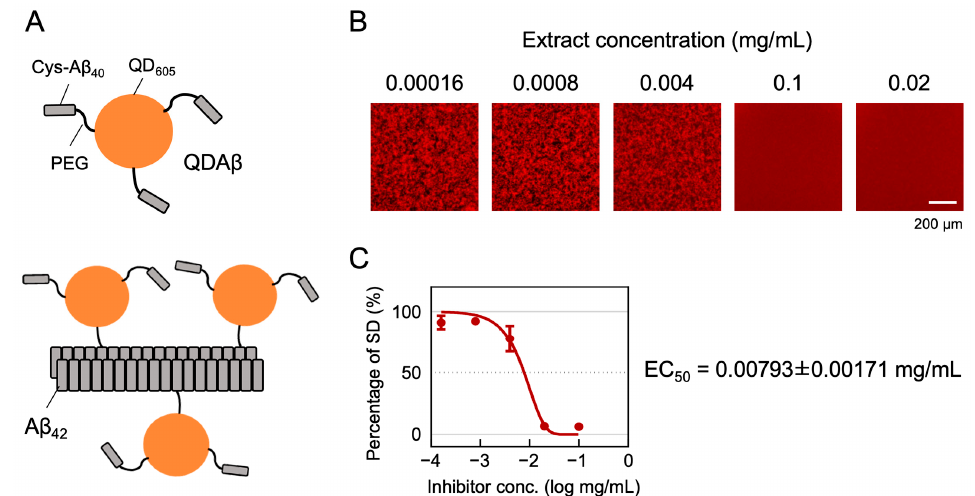
Figure 1. Principle of the MSHTS system for evaluating A β 42 aggregation inhibitory activity. ( A ) QDA β is a fluorescent probe prepared by cross-linking Cys-A β 40 and QD 605 via amino polyethylene glycol (PEG)(top). QDA β co-aggregates with unlabeled A β 42 , allowing A β 42 fibrils to be visualized by fluorescence microscopy (bottom). ( B , C ) Representative analysis of A β aggregation inhibitory activity of Perilla frutescens var. crispa leaf extract. Mixed solutions of 25 μ M A β 42 and extract were added to 1536-well plates and imaged by fluorescence microscopy before and after incubation at 37 °C for 24 h. ( B ) The fluorescence images were trimmed to 432 x 432 pixels, and the SD values, meaning the variation in brightness, were measured. ( C ) The inhibition curve was drawn from SD values, and EC 50 was calculated using Prism GraphPad software.